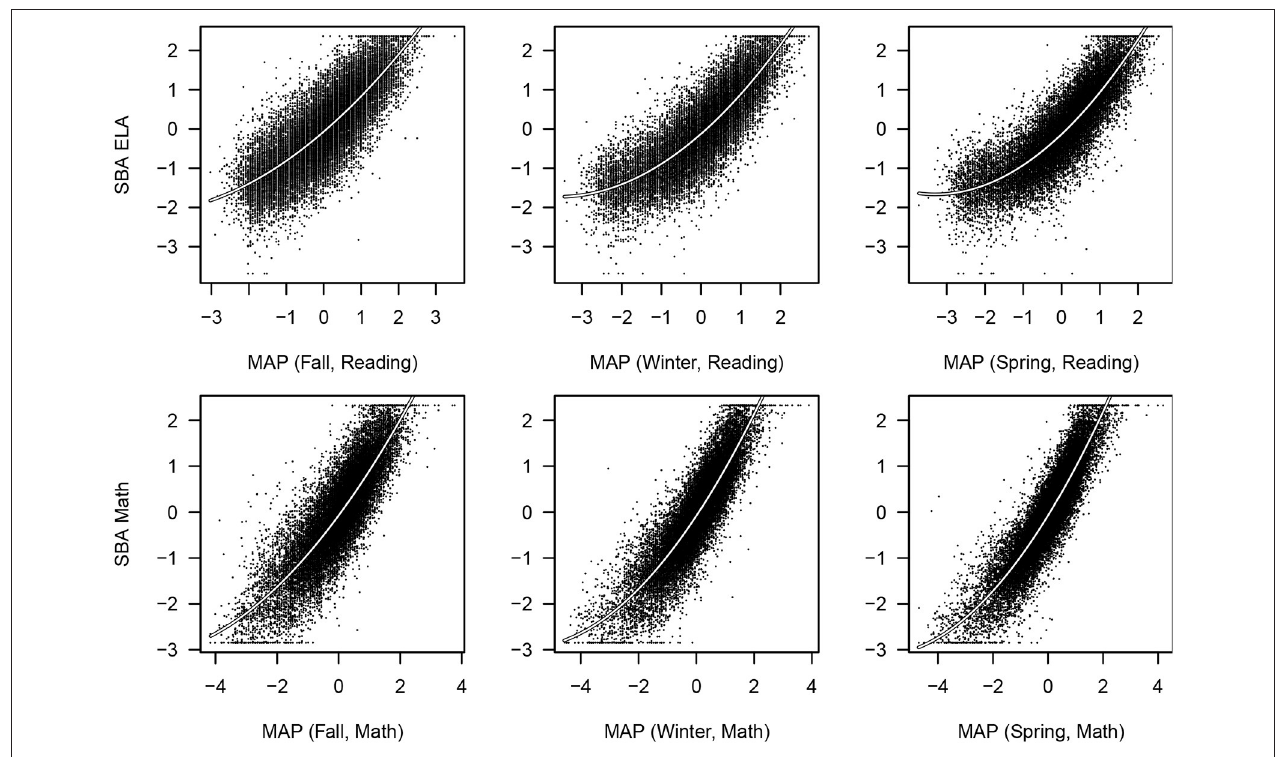
FIGURE 1 | Six scatter plots for 5,000 SBA and MAPs values (jittered).